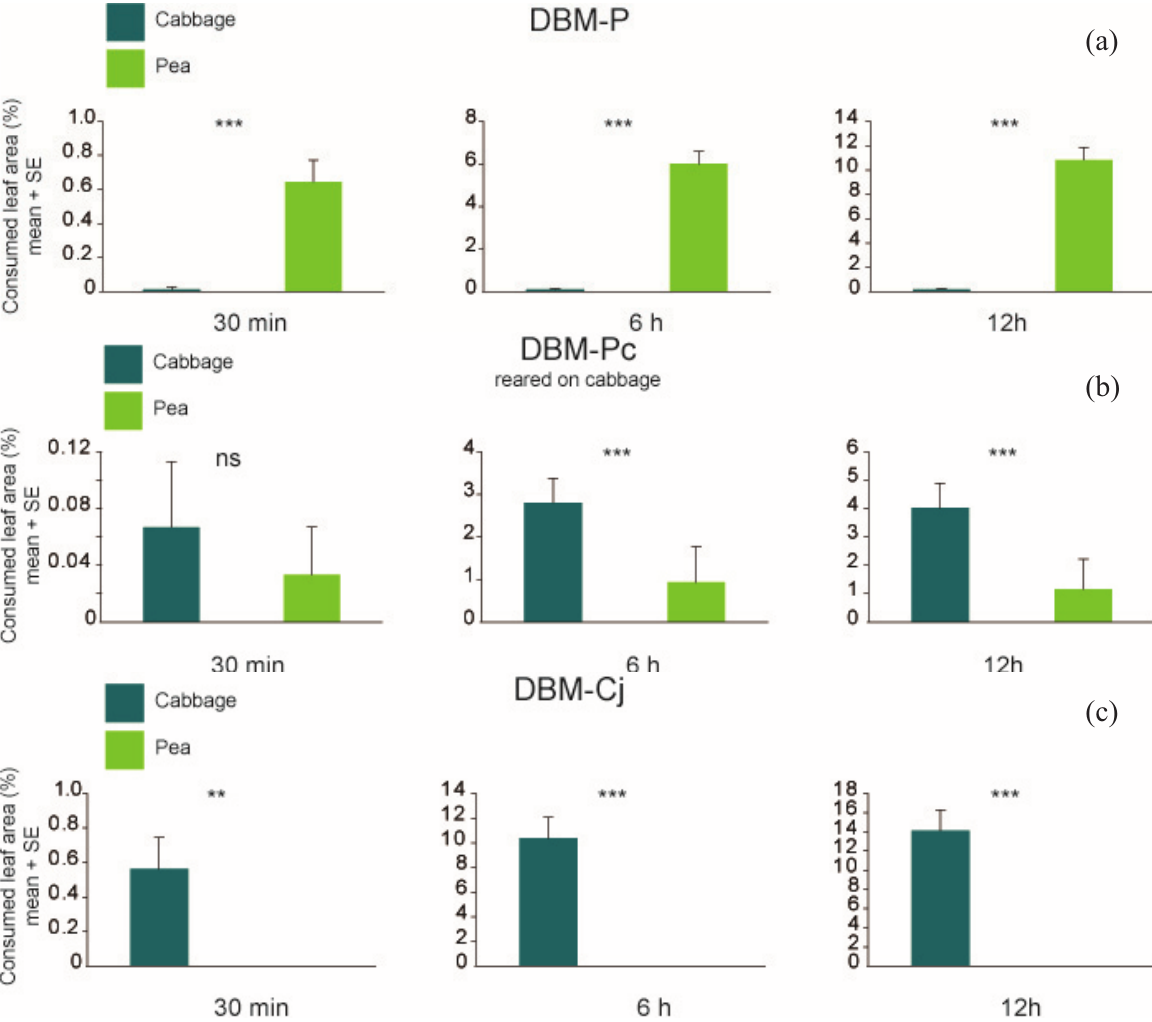
Figure 3. Percentage of consumed leaf area per larva of ( a ) DBM-P ( n = 38); ( b ) DBM-P reared on cabbage ( n = 30) and ( c ) DBM-Cj ( n = 40) after 30 min, 6 h and 12 h. Symbols and abbreviations as in Figure